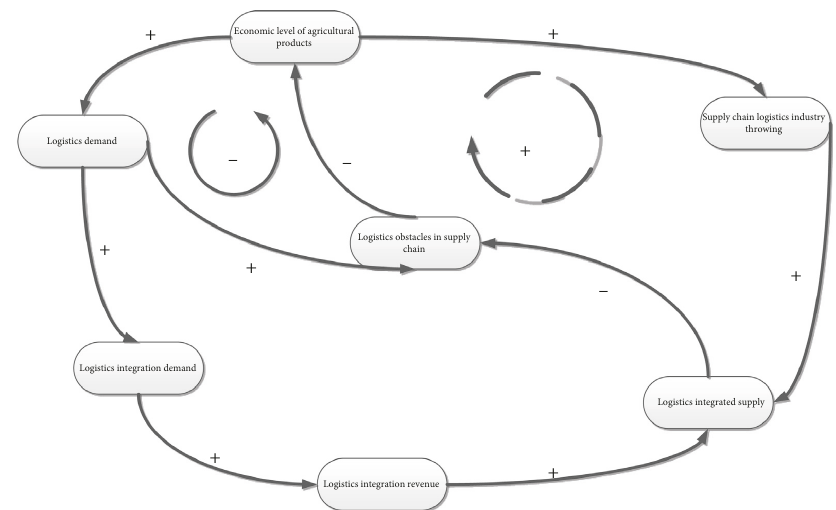
Figure 5: Causality